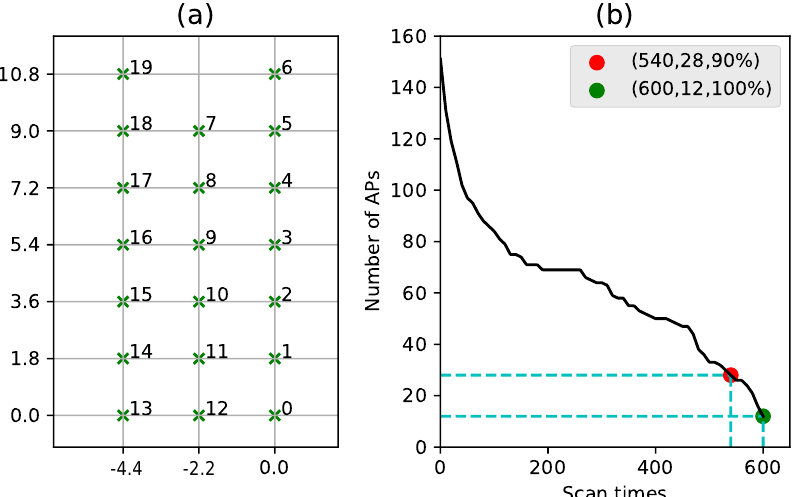
Figure 10. ( a ) The floor map and the reference points’ spatial distribution of the static test. ( b ) A total of 154 APs has been found at the training phase, but it does not mean the 154 APs can be detected for each scan. The Y-axis of ( b ) denotes how many APs can be detected over given times of scans